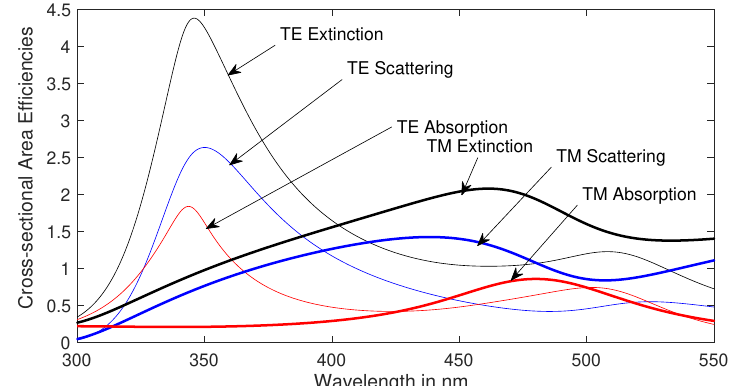
Figure 2. Extinction, scattering and absorption cross-sectional efficiencies (dimensionless) plotted using field solution for the excited TE and TM modes for a 30 nm (nanometer) radius gold